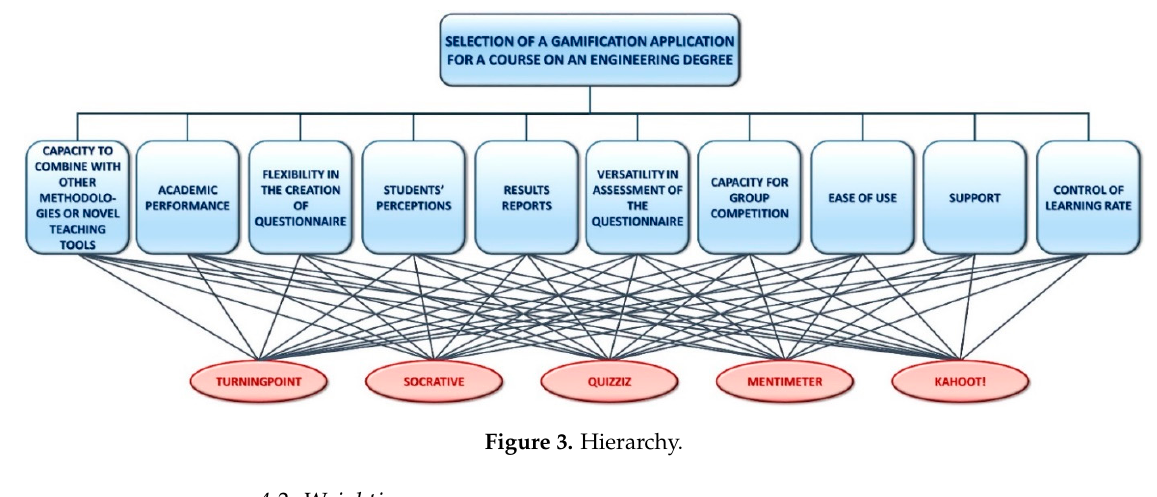
Figure 3. Hierarchy. Figure 3.